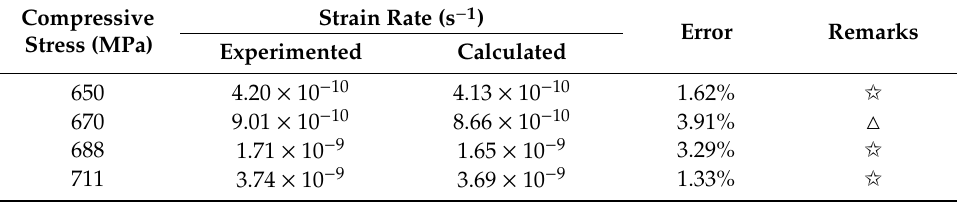
Figure 8. Comparison of calculated with experimental creep strain rate of TA31 titanium alloy. Table 4. Comparison of calculated with experimental creep strain rate of TA31 titanium alloy